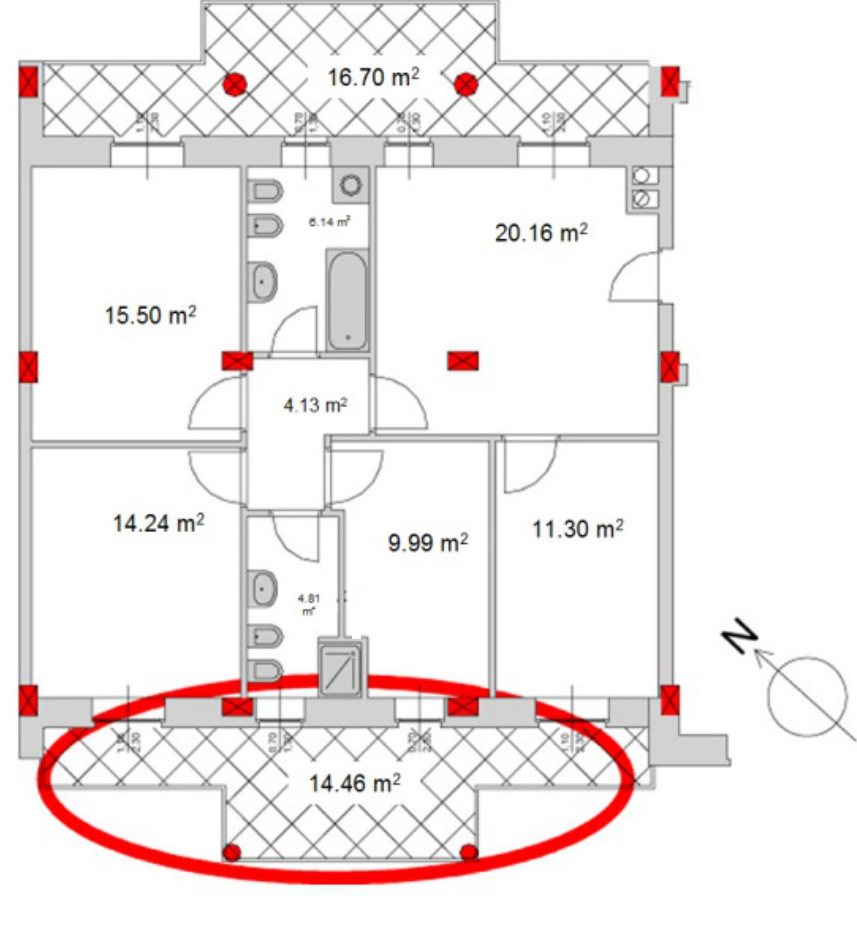
Figure 6. Plan of the flat used as case study with the sunspace.